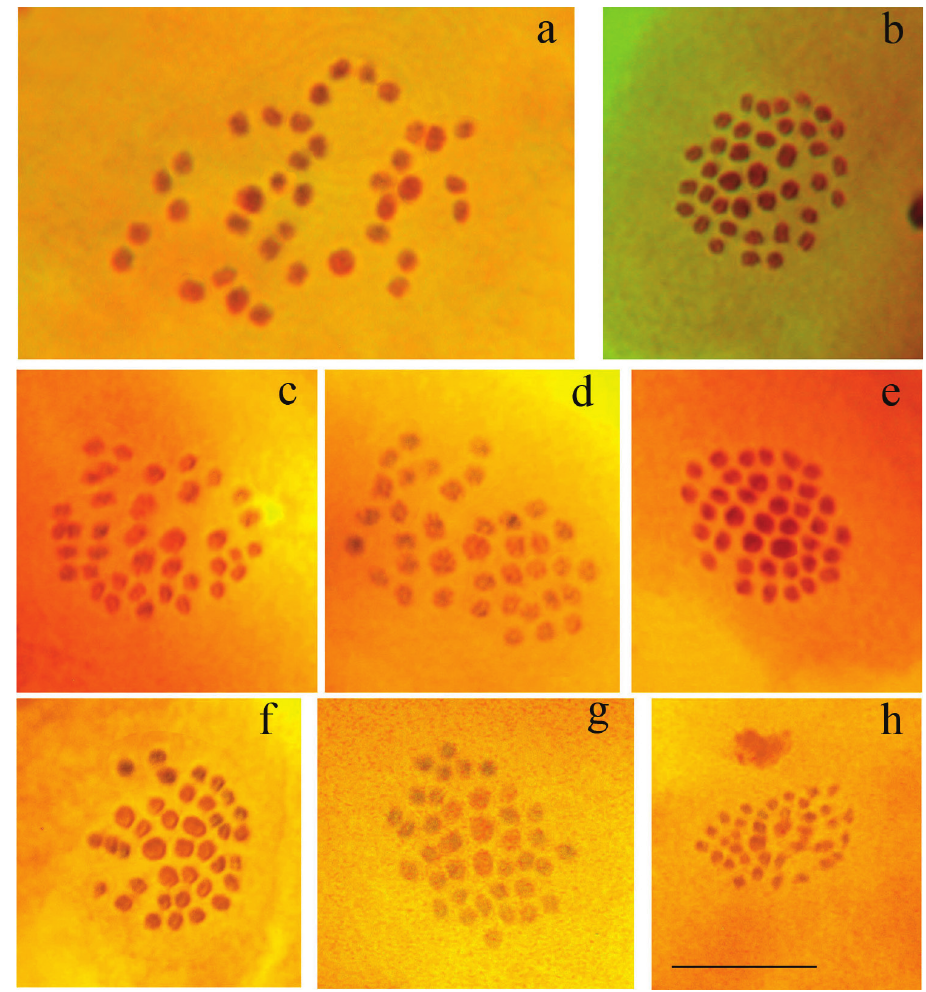
Figure 4. Polyommatus ( Agrodiaetus ) timfristos karyotypes. Bar = 10 µ. a P . timfristos , sample LR08D205, Central Greece, Parnassos, first prometaphase of meiosis, n=38 b P . timfristos , sample LR08D205, Cen- tral Greece, Parnassos, MI, n=38 c P . timfristos , holotype, sample LR08D247, Central Greece, Timfristos, MI, n=38 d P . timfristos , sample LR08D255, Central Greece, Timfristos, MI, n=38 e P . timfristos , sample LR08D258, Central Greece, Timfristos, MI, n=38 f P. timfristos , sample LR08D258, Central Greece, Timfristos, MI, n=38 g P . timfristos , sample LR08D273, Central Greece, Timfristos, MI, n=38 h P . timfristos , sample LR08D274, Central Greece, Timfristos, MII, n=38. of the 221-specimen dataset recovered the P. admetus and P. dolus species groups as distinct monophyletic lineages. This is consistent with the previous conclusions (Wie- mers 2003, Kandul et al. 2004, 2007, Lukhtanov et al. 2005, 2015, Vila et al. 2010, Dincă et al. 2013a). The tree divided into two parts ( P. admetus and P. dolus groups) is shown in Figures